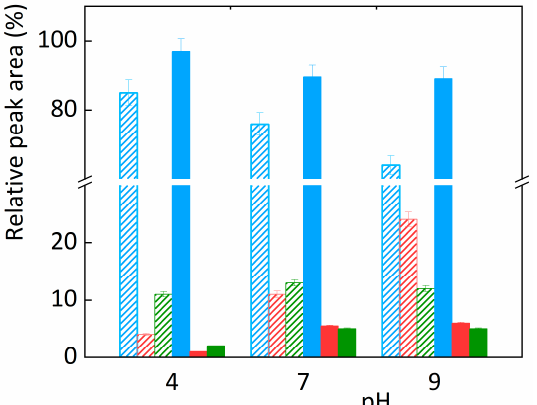
Figure 5. Abacavir degradation level as a function of pH and formation of oxidation products OP1 (red colour) and OP2 (green colour) using platinum (line pattern) and BDD (full colour) electrodes for 10 min at pH = 4.0, 7.0, and 9.0.